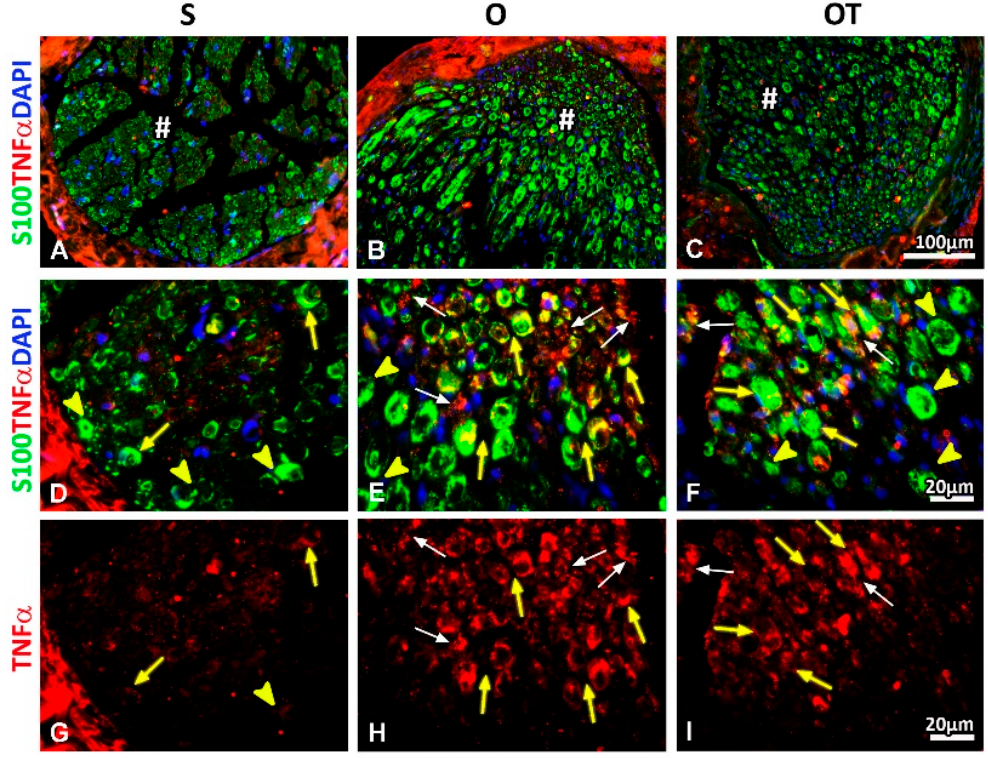
Figure 7. Effects of PNI and the B vitamins treatment on expression of proinflammatory cytokine tumor necrosis factor alpha (TNF- α ) in SCs. Femoral nerve cross sections obtained from the: sham (S: A , D , G ), operated (O: B , E , H ) and operated and treated with the vitamin B (B1, B2, B3, B5, B6, and B12) complex (OT: C, F, I ) group immunostained for TNF- α (red) demonstrated strong increase of immunofluorescence intensity in the O group (H) compared to the S group ( G ) at the 14th dpo. Immunofluorescence staining for TNF- α protein was observed in some ( E , F , H , I , yellow arrows), but not all SCs ( E , F , H , I , yellow arrow heads) as detected by co-localization with S100 immunostaining (green). DAPI (blue) was used for visualizing cell nuclei. Administration of 14 injections of the vitamin B complex (OT group) reduced TNF- α expression ( I ). TNF- α immunoreactivity was detected in some S100 + myelinated SCs ( F , yellow arrows). In addition, TNF- α immunoreactivity was demonstrated in macrophages with the M2-like morphology ( E , F , H , I , white arrows). # indicates where the high magnification micrographs were taken from. Scale bars: A – C = 100 µ m, D – I = 20 µ